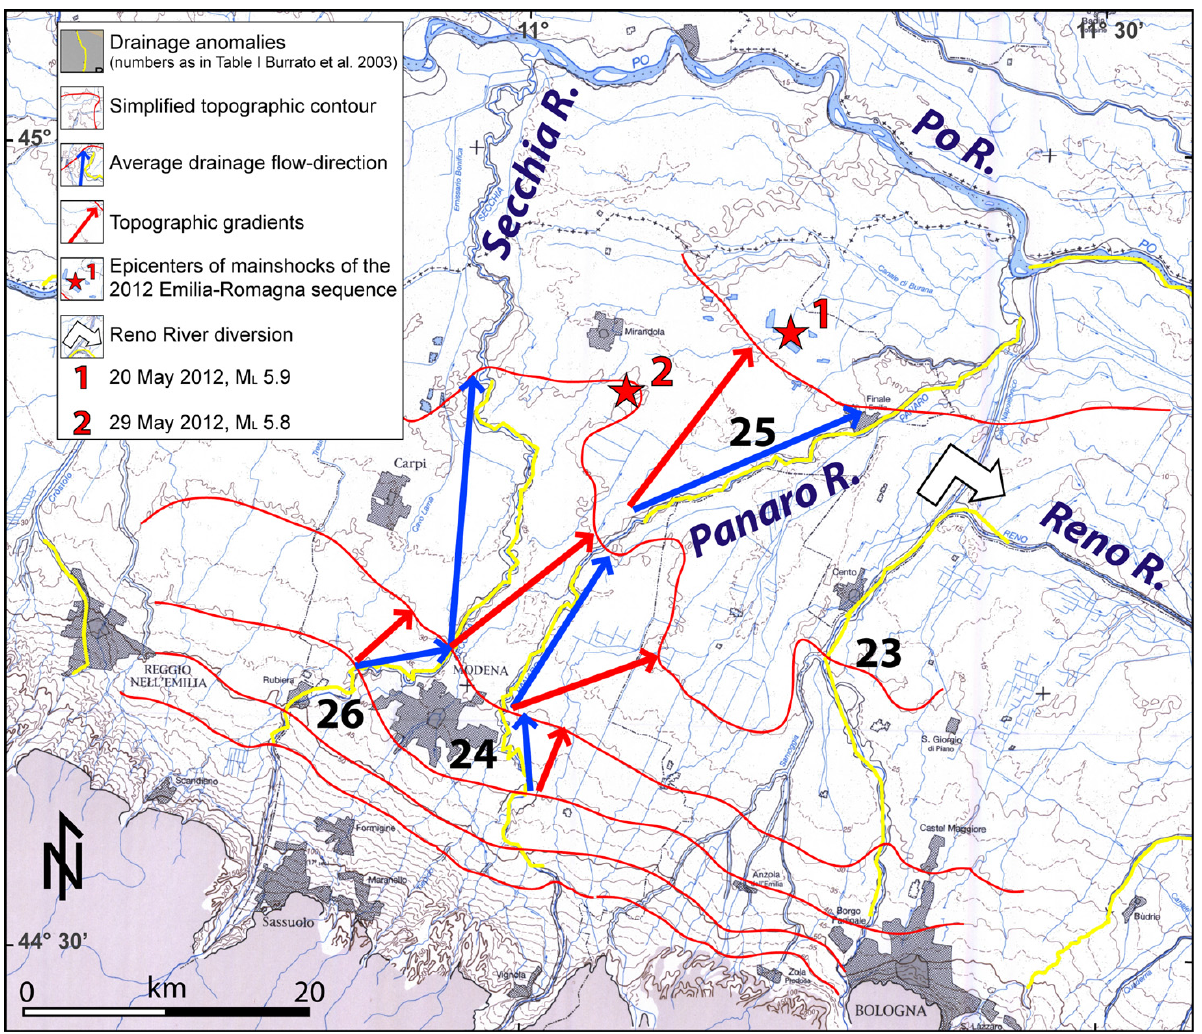
Figure 2. Drainage anomalies in the epicentral area of the 2012 Emilia-Romagna seismic sequence. The drainage should flow following the maximum regional topographic gradient; i.e., in a direction perpendicular to the smoothed topographic contour lines. The mean flow direction of each river is cal- culated between the contour lines. An anomaly is identified when the drainage and the topographic vectors diverge by >10˚ along a >5-km-long section of the river course. Basemap is from MURST [1997b].